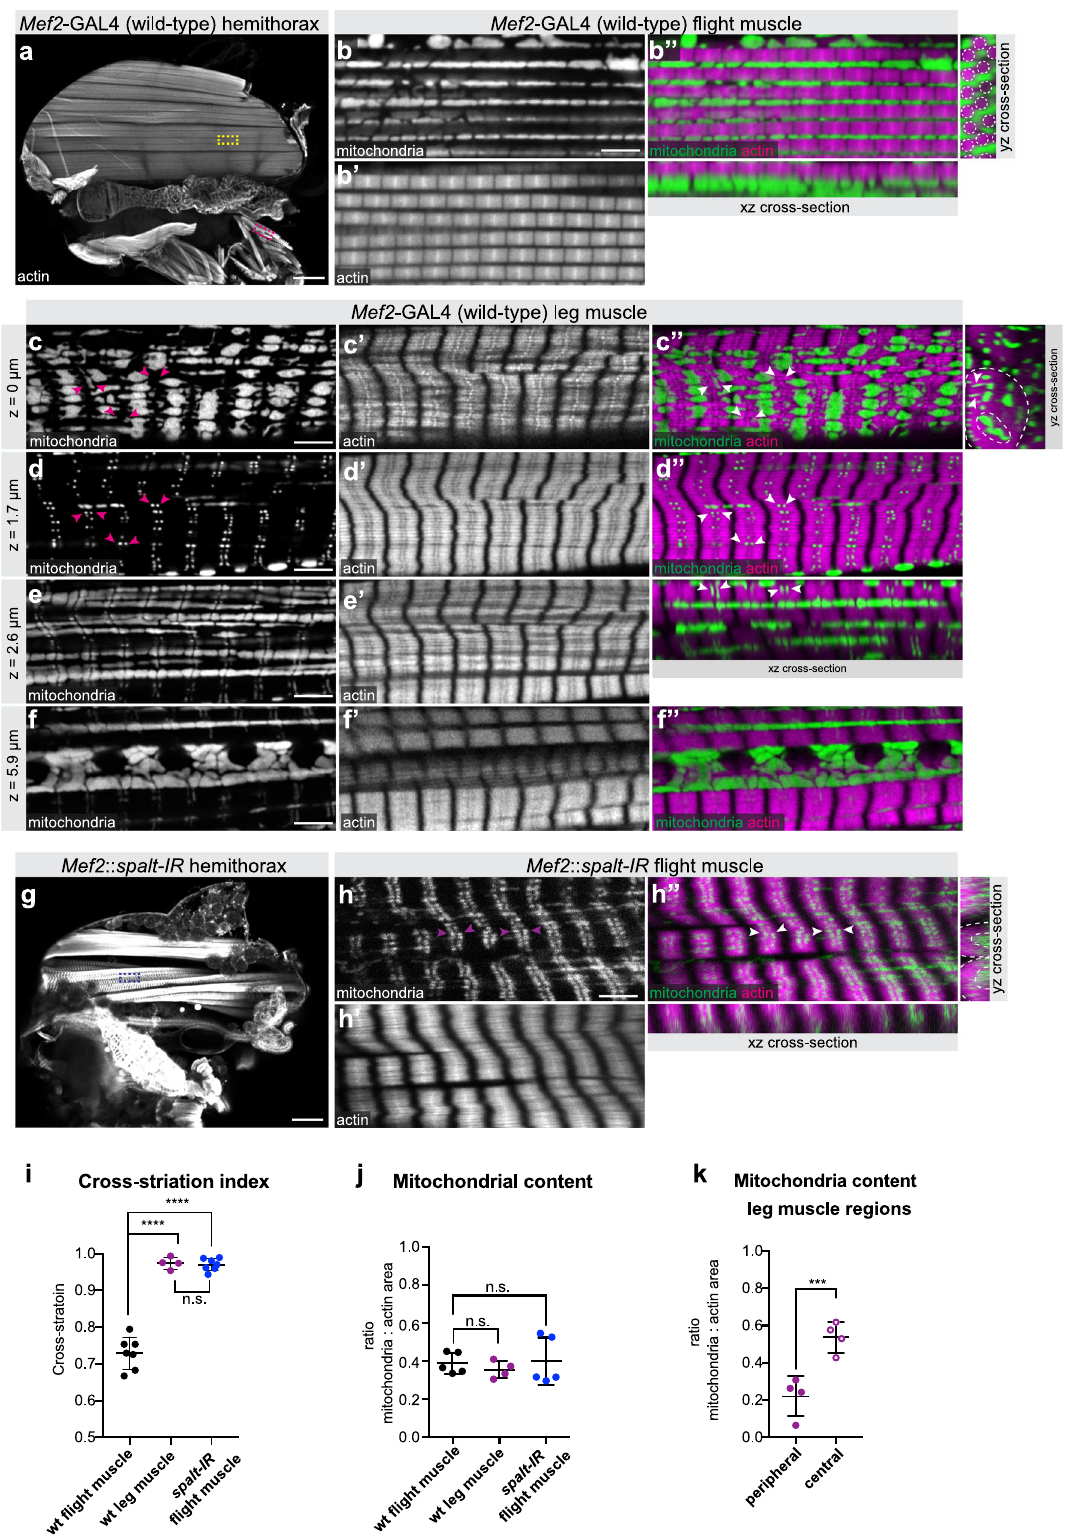
enabled us to segment and reconstruct individual mitochondria in three dimensions using a deep learning network (Fig. 2b, c, Supplementary Fig. 2a – f and Supplementary Movie 1). These data show that the average volume of fl ight muscle mitochondria is ~3 – 4 µm 3 (Fig. 2d). Most mitochondria adopt a simple elongated ellipsoid-like shape with the long axis of the ellipsoid oriented